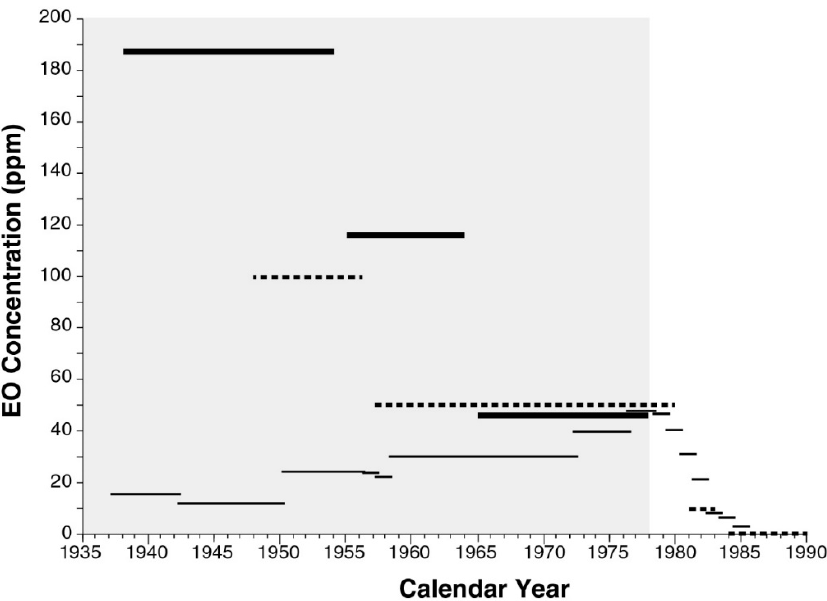
Figure 5. Comparison of E/IH (thick lines) and NSR (thin lines) exposure model estimates of occupational respiratory exposures to EO in facilities that sterilized medical/health products and prevailing ACGIH TLV limits for EO (dashed lines). Shaded area represents the period during which very limited or (pre-1976) no contemporaneous measurements were available to validate NSR model predictions and during which no EO-specific regulations were in place to limit occupational EO exposures.